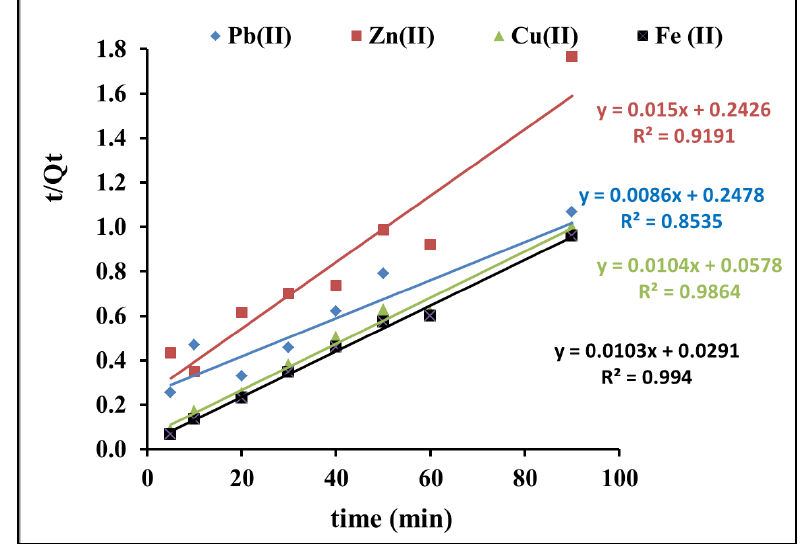
Figure 5. The pseudo-second-order model of the adsorption of Pb(II), Zn(II), Cu(II), and Fe(II) onto RC-MWS. Table 1. Parameters for the kinetics of the adsorption of Pb(II), Zn(II), Cu(II), and Fe(II) onto RC- MWS.